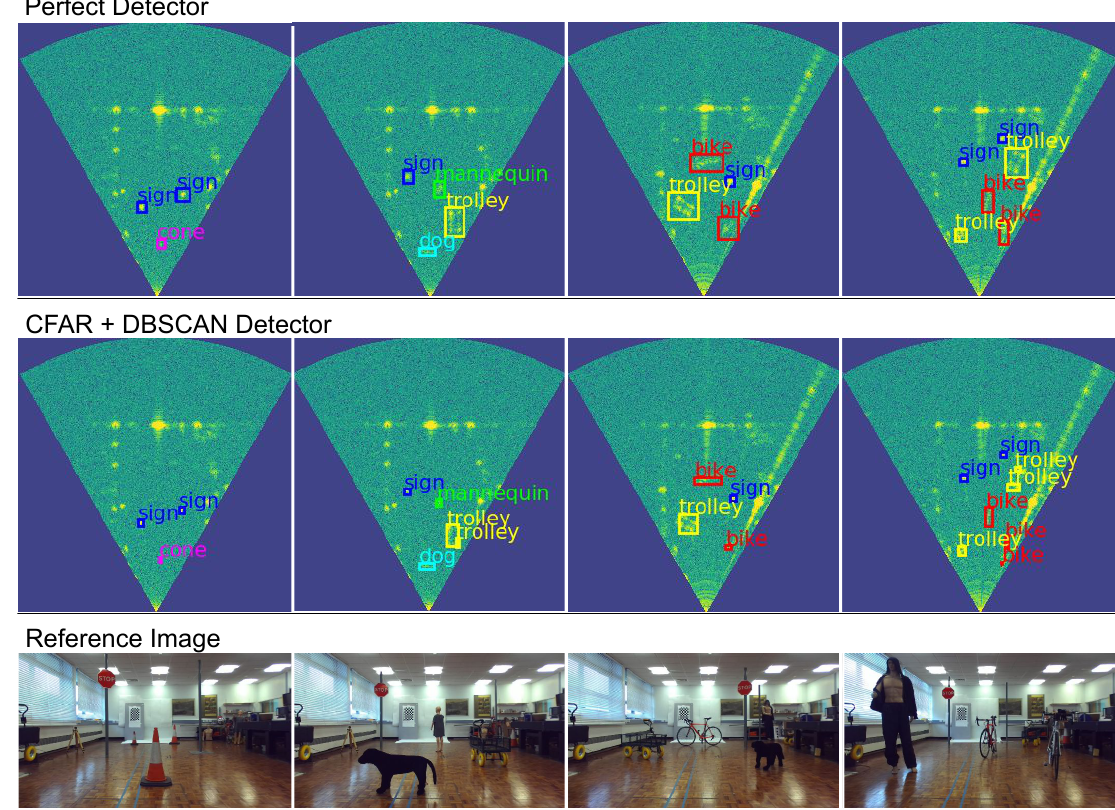
Figure 10. Qualitative results using RADIO for perfect detection, the constant false alarm rate (CFAR) + DBSCAN + network pipeline, and the corresponding video images.